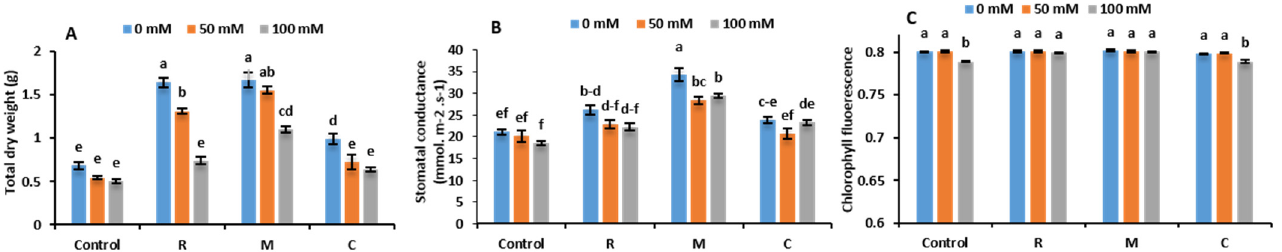
Figure 2. ( A ) total dry weight, ( B ) stomatal conductance and ( C ) chlorophyll fluorescence of lettuce plants grown without (0 mM NaCl) or with (50 and 100 mM NaCl) salt stress, and subjected to different biostimulant treatments. Control: untreated plants, R: inoculated with PGPR, M: inoculated with arbuscular mycorrhizal fungi, C: amended with compost. Data are mean ± SE of 10 biological replicates. Means followed by the same letters are not significantly different at p < 0.05 (Tukey’s HSD).